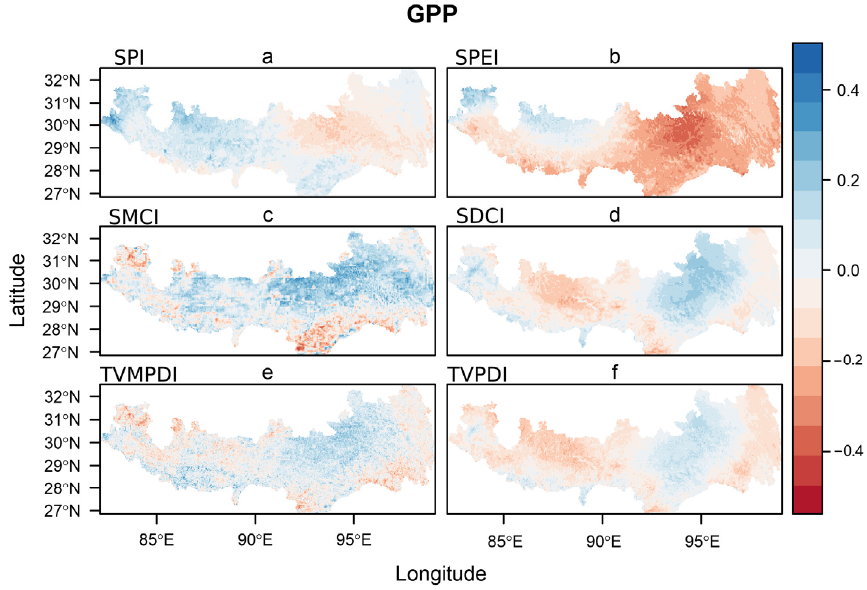
Figure 5. Temporal correlation between GPP and dryness indices, including SPI ( a ), SPEI ( b ), SMCI ( c ), SDCI ( d ), TVMPDI ( e ) and TVPDI ( f ).